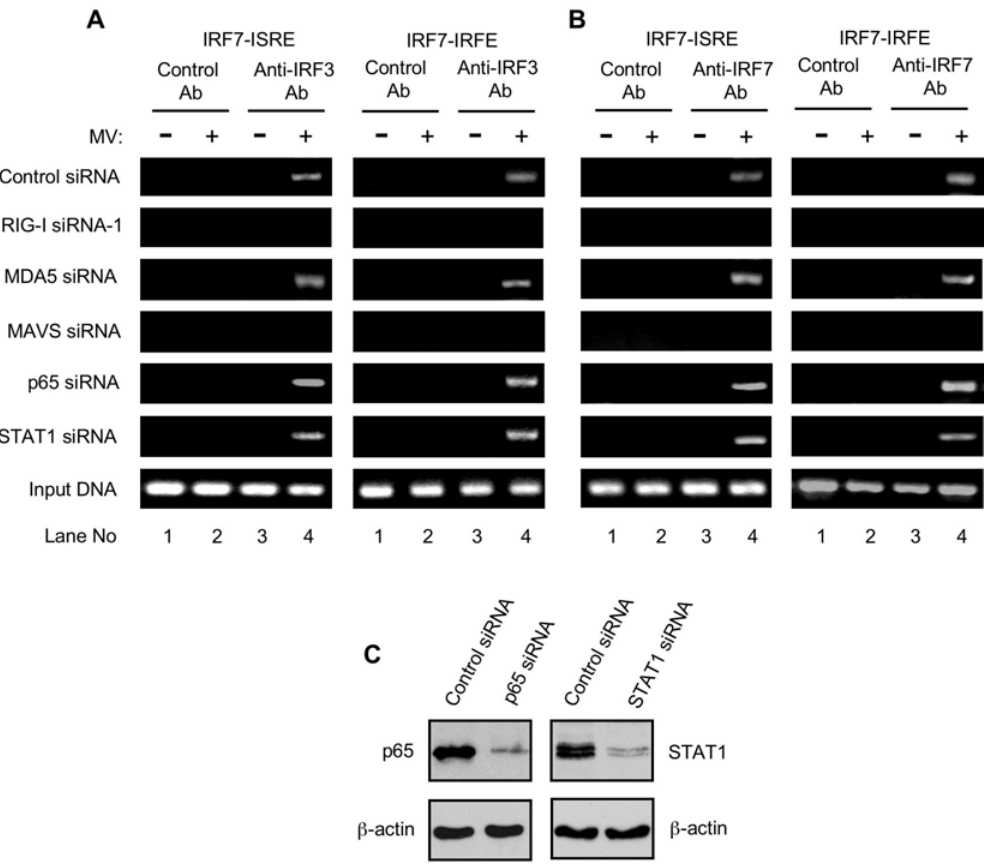
Figure 6. MV induces IRF3 and IRF7 binding to the endogenous IRF7 promoter in primary human macrophages. (A, B) Chromatin immunoprecipitation assay. IRF3 and IRF7 binding to the ISRE and IRFE in the endogenous IRF7 promoter was determined in control siRNA pHMs or various siRNA pHMs as indicated after MV infection for 12 h using PCR to detect IRF7 ISRE and IRFE in immunoprecipitated chromatin fragments. Lanes 1 and 2 are the PCR results for immunoprecipitated samples with the control antibody (Ab). Lanes 3 and 4 show PCR amplification of target sequences in immunoprecipitated chromatin fragments with anti-IRF3 (A) or anti-IRF7 (B) antibody. Input represents PCR amplification of the total input DNA in each sample from the corresponding treatment. (C) pHMs were transfected with control siRNA or specific siRNAs as indicated. The cells were analyzed 72 h later by immunoblotting for protein levels of NF- k B p65 (left) and STAT1 (right). b -actin was used as control.